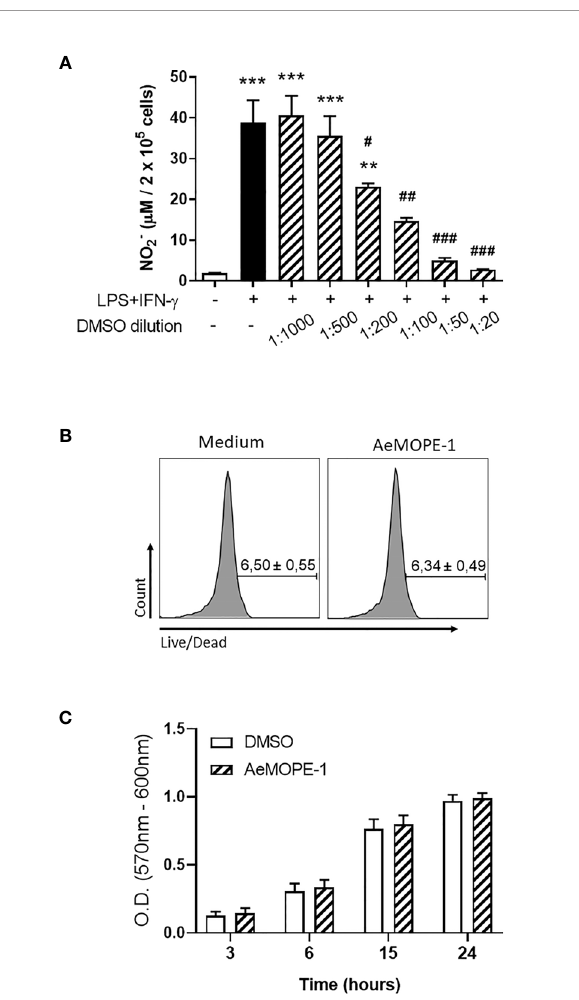
FIGURE 3 | Neither DMSO nor syn-AeMOPE-1 are cytotoxic to macrophages at the dilution used in the experiments. (A) Thioglycolate- elicited peritoneal macrophages were pre-incubated with increasing concentrations of DMSO (indicated in the fi gure), stimulated with LPS+IFN- g (10 ng/mL of each) for 48 hours, and nitric oxide production was measured by Griess reaction. (B) Thioglycolate-elicited peritoneal macrophages were incubated with DMSO (1:1000) or AeMOPE-1 (2 µm) for 4 hours, followed by staining with Live/Dead Viability/Cytotoxicity Assay Kit and evaluation by fl ow cytometry. Gating strategy and representative plots are presented in Supplementary Figure 3A . (C) Thioglycolate-elicited peritoneal macrophages were incubated with DMSO (1:1000) or AeMOPE-1 (2 µm) for 24 hours and the basal metabolic activity was monitored at different time points by a colorimetric assay. Results are expressed as the mean ± SEM from three (A, B) or fi ve (C) independent experiments assayed in duplicates (A, B) or triplicates (C) . ** P ≤ 0.01 and *** P ≤ 0.001 versus unstimulated/ untreated cells; # P ≤ 0.05, ## P ≤ 0.01 and ### P ≤ 0.001 versus LPS+IFN- g - stimulated cells – One-way